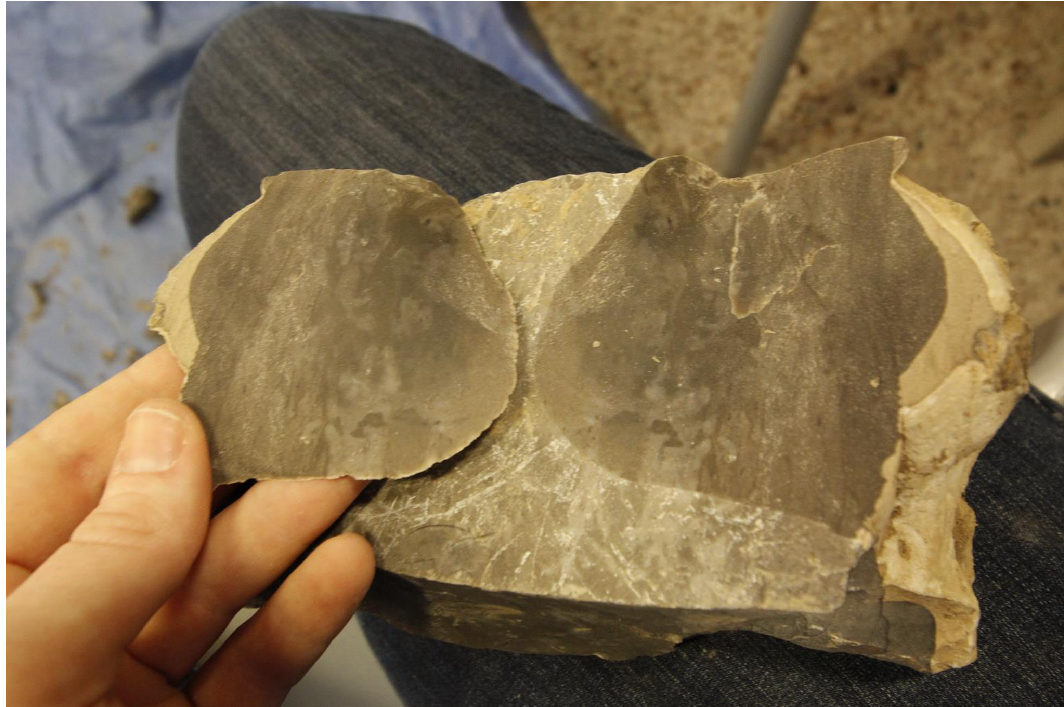
Figure 3. The chert gathered at the quarry made for fine knapping practice.